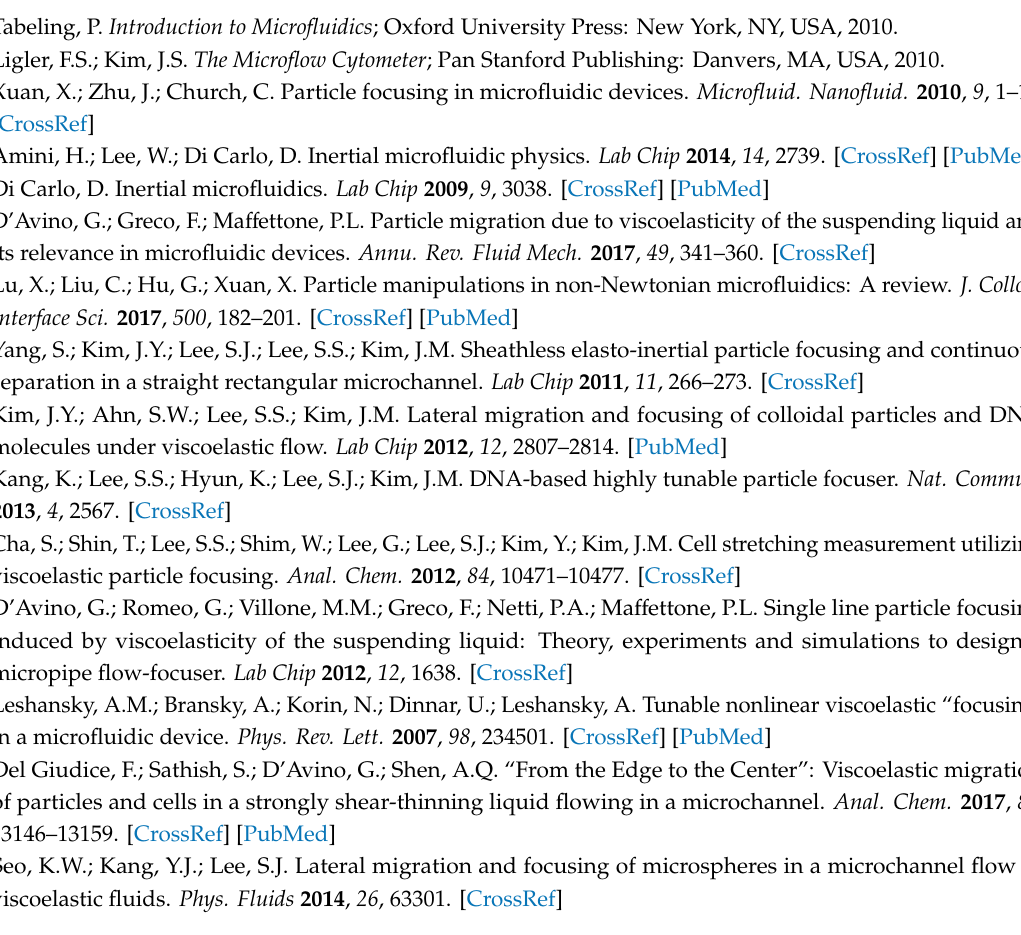
Figure S1: particle distributions according to flow rates in 6.4 wt % poly(vinyl pyrrolidone) (PVP) aqueous solution; Figure S2: probability of localization of particles in xanthan gum (XG) solution in deionized water (XGDI) and in phosphate bu ff ered saline (PBS) solution (XGPBS); Figure S3: pressure drops measured between the channel inlet and outlet in the xanthan gum (XG) solutions (XGDI and XGPBS) and poly(vinyl pyrrolidone) (PVP) solution